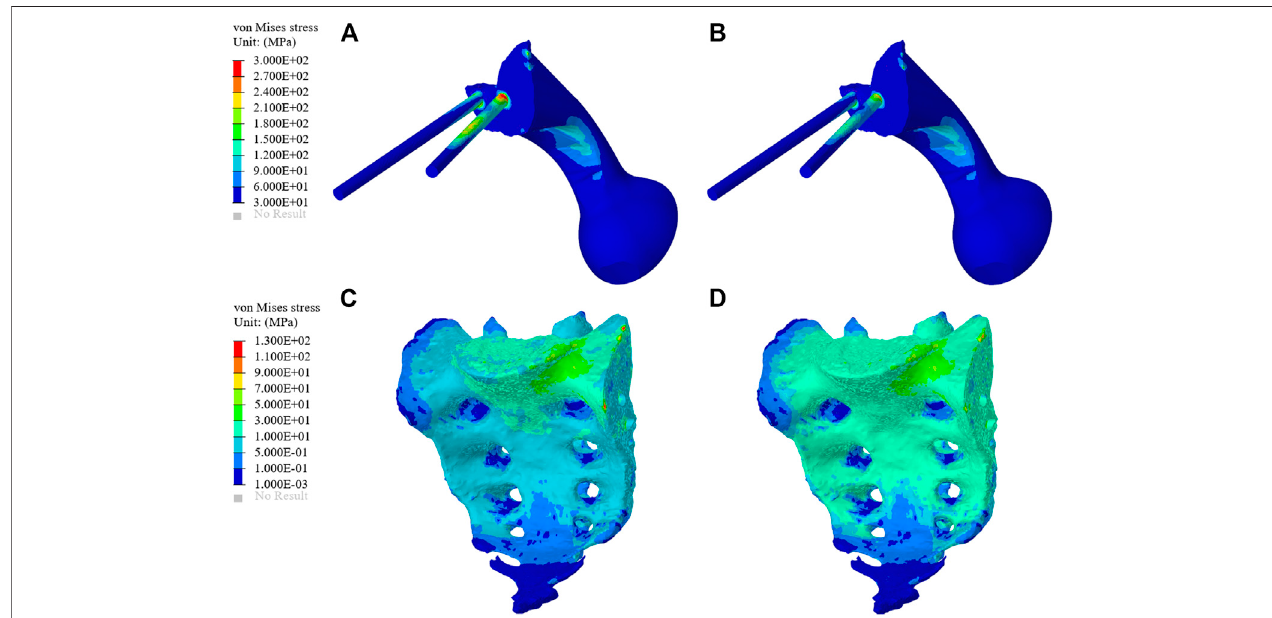
FIGURE6| Stresscomparison oftheprosthesisand sacrum betweentheoriginalgroupand theoptimizationgroup. (A) Thestressdistribution ofprosthesis inthe originalgroup. (B) Thestressdistributionofprosthesisintheoptimizationgroup. (C) Thestressdistributionofthesacrumintheoriginalgroup. (D) Thestressdistribution of the sacrum in the optimization group.